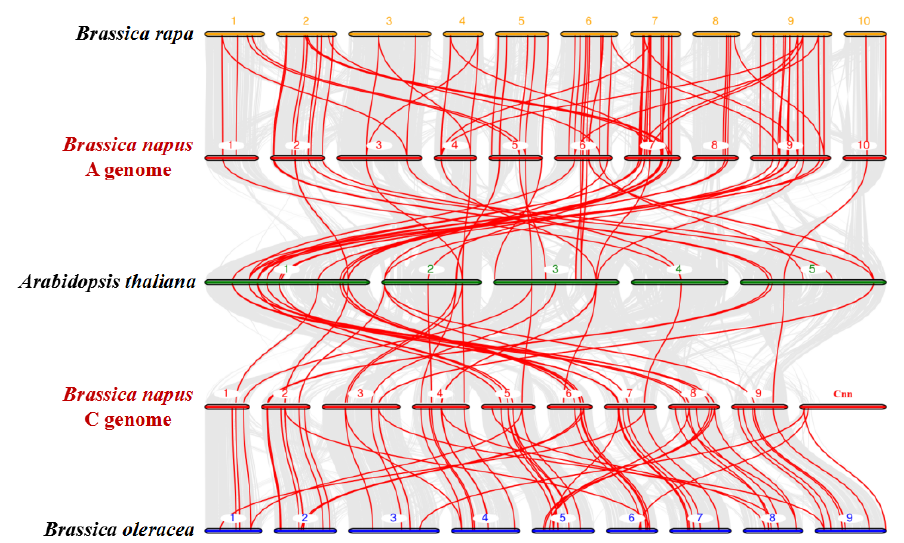
Figure 4. Synteny analysis of the NPF genes in Brassica napus , B. rapa , B. oleracea and Arabidopsis thaliana chromosomes. Gray lines in the background indicate the collinear blocks within B. napus and other plant genomes, while the red lines highlight the syntenic NPF gene pairs. Genes located on B. napus A genome are syntenic with genes of B. rapa and A. thaliana , while genes located on B. napus C genome are syntenic with genes of B. oleracea and A. thaliana .